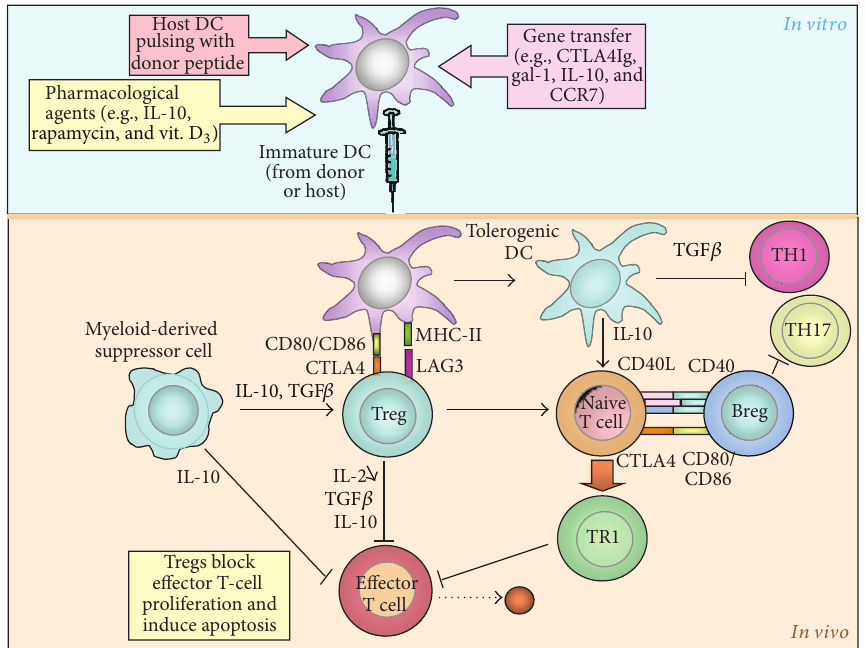
Figure 1: Regulatory T cells (Tregs) are present in the host at the time of transplantation and are recruited to the allograft. They respond to donor alloantigen through cross-reactivity and inhibit T-cell proliferation in draining lymphoid tissue. Tolerogenic DCs favor the generation of Tregs from naive T cells, which then block effector T-cell proliferation while also triggering apoptosis of these cells. They inhibit TH1 cells. These processes facilitate allograft acceptance through several mechanisms including the production and release of immunosuppressive cytokines, such as IL-10 and TGF 𝛽 (modified from Wood et al.